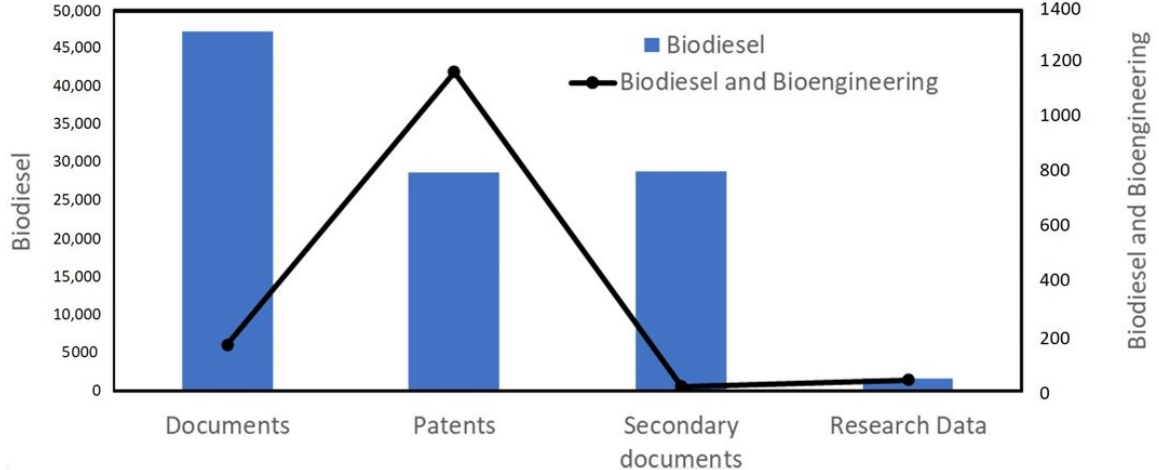
Figure 3. Different types of publications with keywords ‘biodiesel’ and ‘biodiesel and bioengi- neering’.